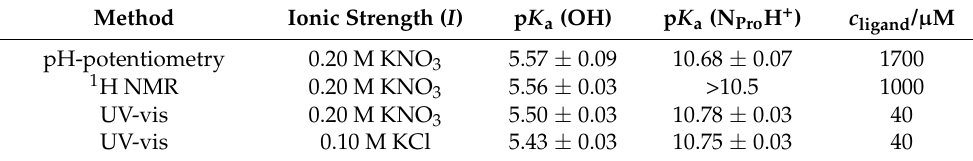
Figure 1. ( a ) UV-vis spectra of HQNO 2 -L-Pro recorded in the pH range 2–12. ( b ) Concentration distribution curves calculated with the determined p K a values and absorbance values at 460 nm ( ■ ) with the fitted line (solid line). { c ligand = 40 μM; I = 0.20 M KNO 3 ; l = 1 cm; t = 25.0 °C}. Table 1. p K a values of HQNO 2 -L-Pro determined by various methods. { t = 25.0 ◦